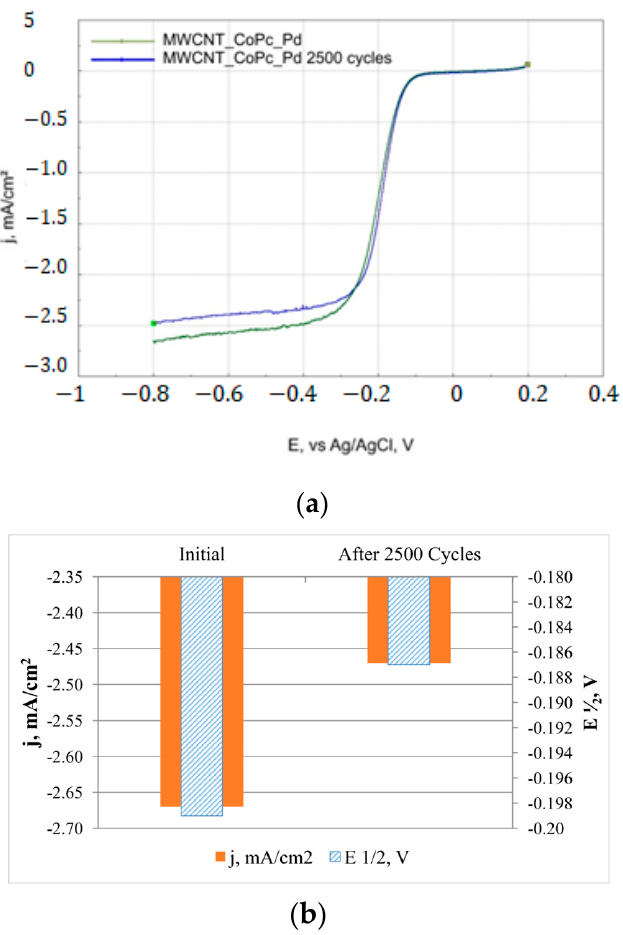
Figure 12. Corrosion resistance test of the MWCNT_CoPc_Pd catalyst: ( a ) LV before and after 2500 cycles; ( b ) comparative diagram of diffusion current density ( − 0.80 V) before and after 2500 cycles.